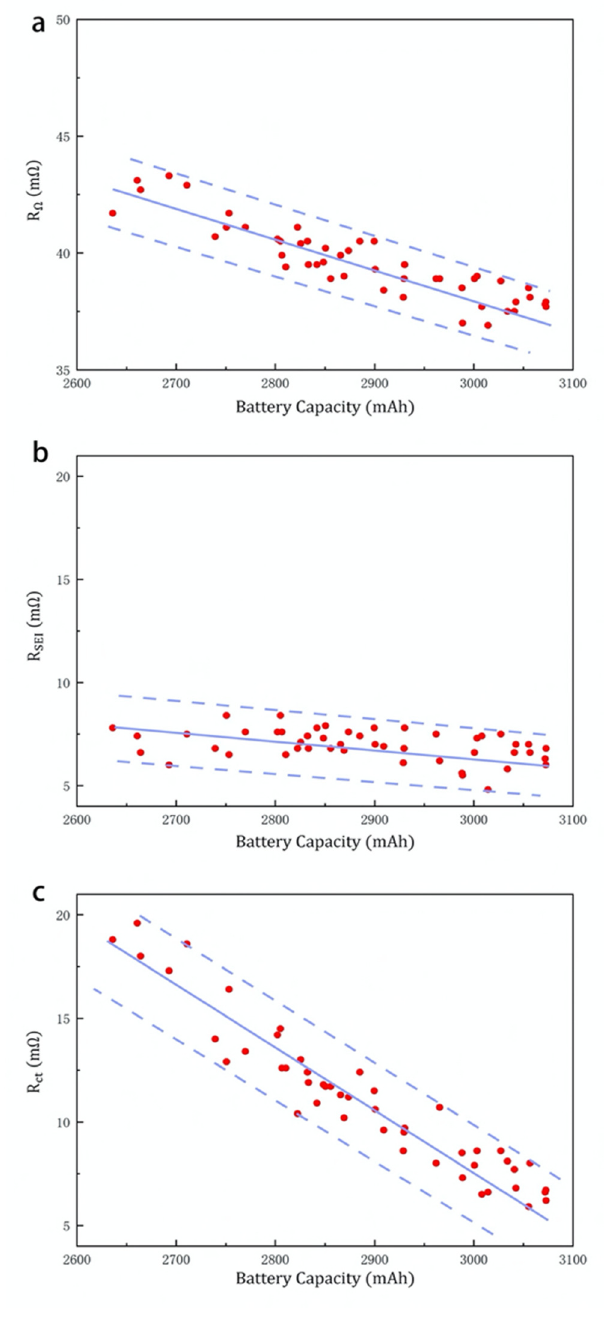
Figure 7. Internal parameters of different capacity batteries: ( a ) R Ω , ( b ) R SEI , ( c ) R ct . The data are measured by static fast DCIS.